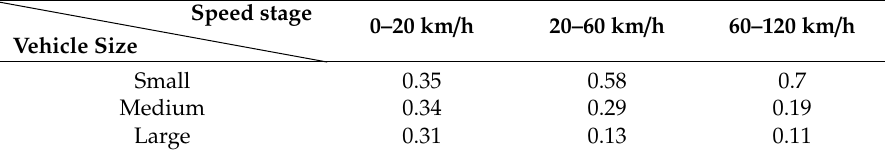
Table 5. Occurrence frequency ratios of vehicle sizes at different speed stages.